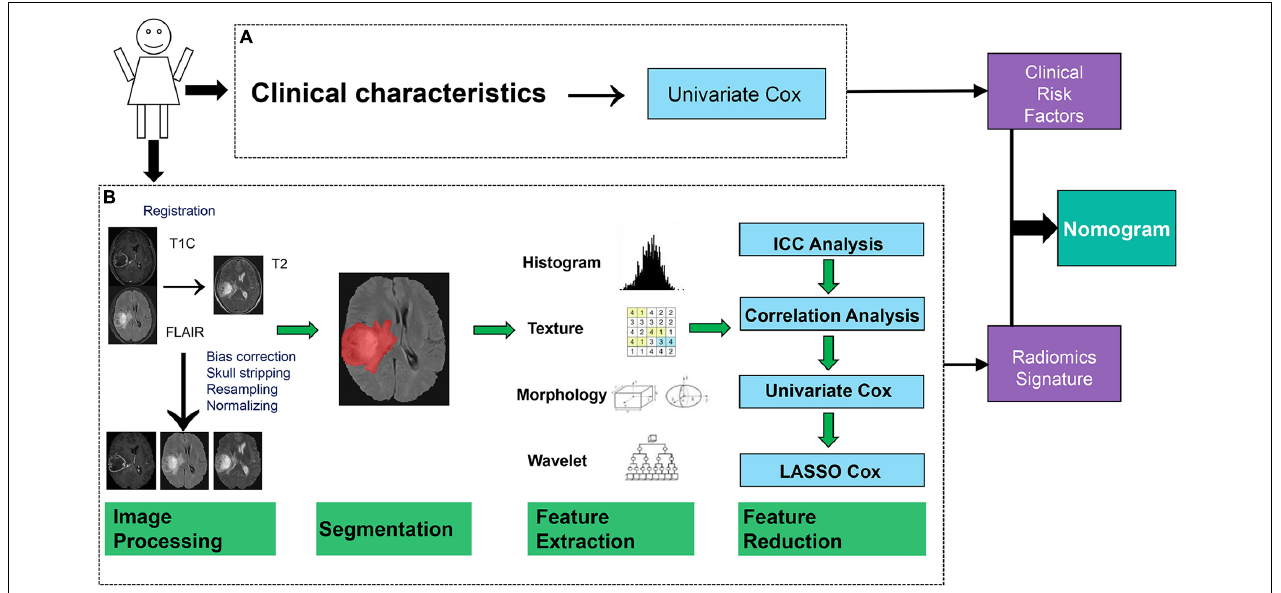
FIGURE 1 | Data flowchart of the study. (A) Module of the clinical characteristic analysis. (B) Module of the radiomics analysis.